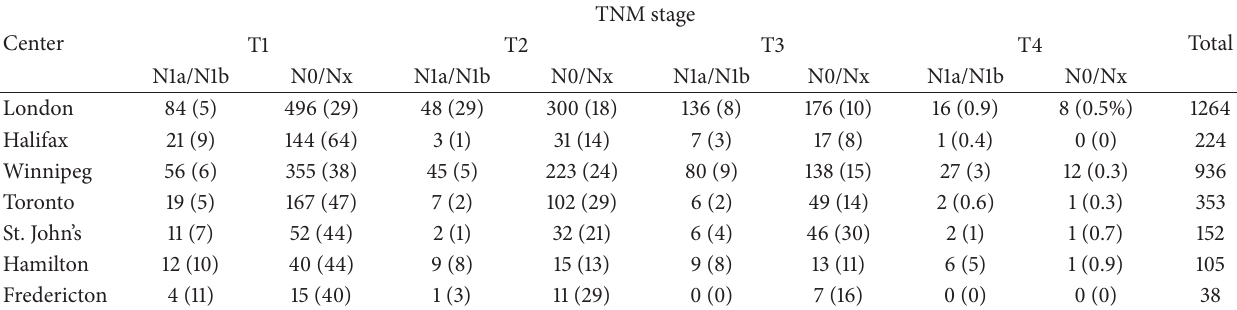
Table 3: Total number of patients with well-differentiated thyroid cancer by stage and